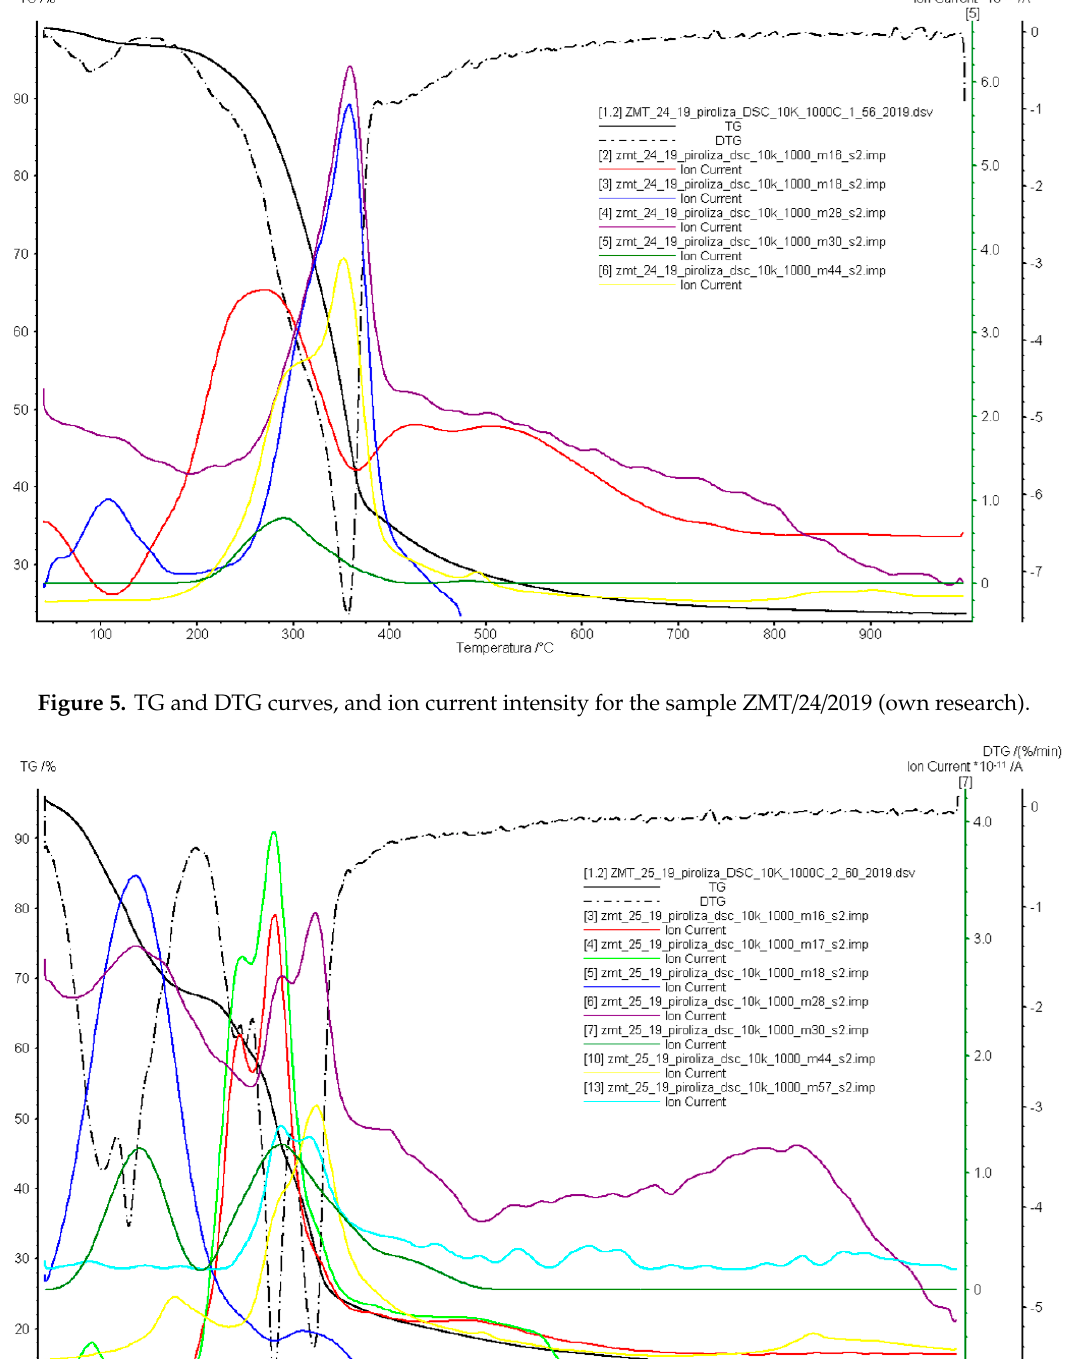
Figure 4. TG and DTG, curves and ion current intensity for the sample ZMT/20/2019 (own research).